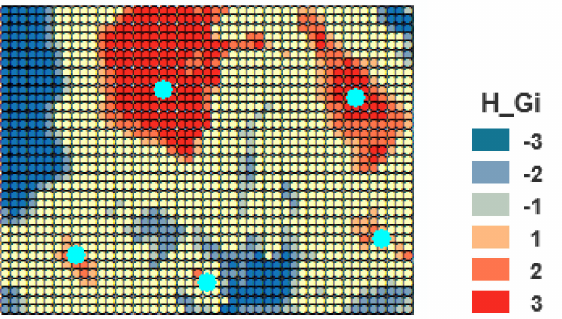
Figure 19. The distribution map for the third dataset using our proposed